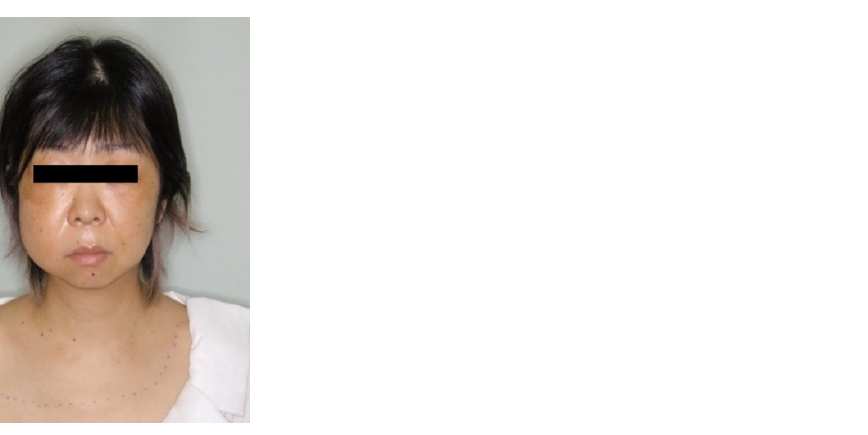
Figure 2. Patient (Case 1) had swelling from her right eyelid/cheek to both necks/clavicle area.